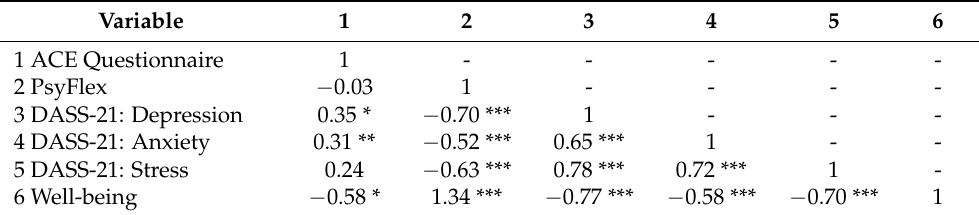
Table 2. Bivariate correlations among variables for mediation